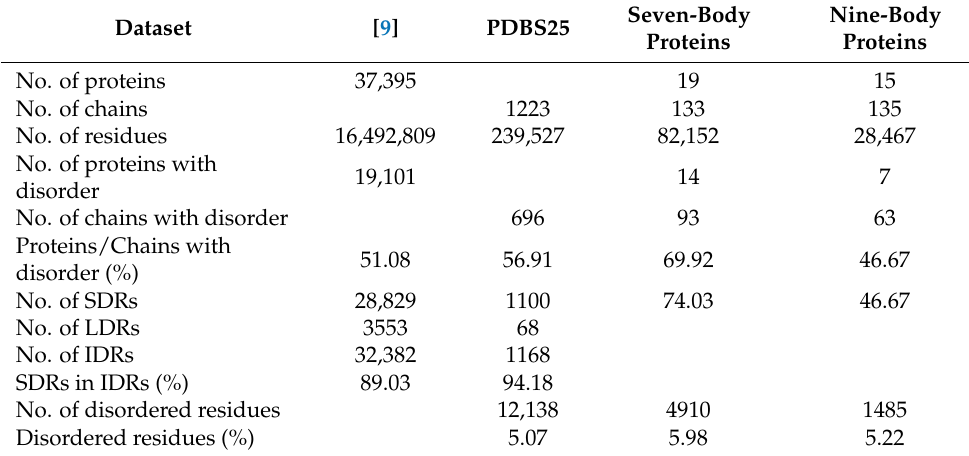
Table 1. Disorder residues in the